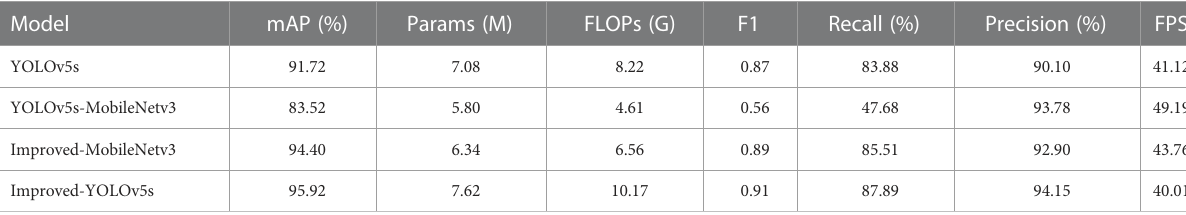
TABLE 5 Comparison results of different backbone models.